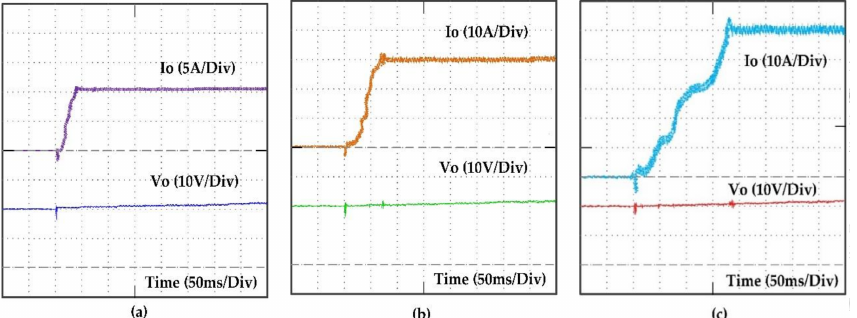
Figure 15. The supercapacitor bank (153 Wh) with an initial charging voltage 20 V connected to DAB-IBDC converter. The output voltage and current waveform during the soft-start period ( a ) 500 W, ( b ) 1.5 kW and ( c ) 2.5